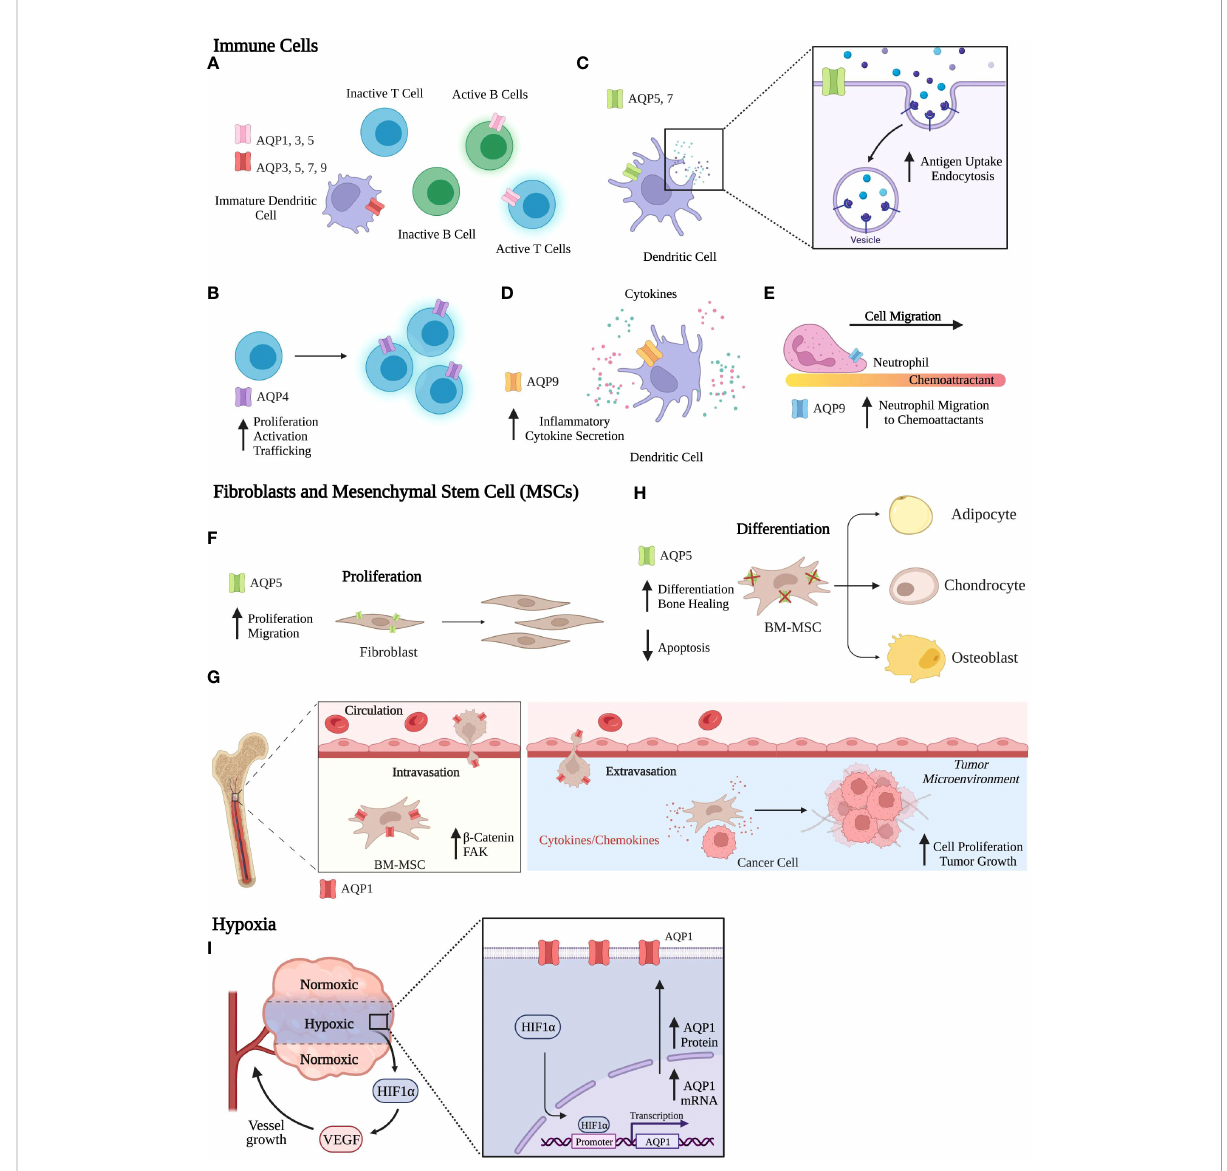
FIGURE 3 Functional Roles of Aquaporins. (A-E) Immune Cells . (A) AQP expression across various immune cells. (B) AQP4 is involved in T cell activation and proliferation. (C) In dendritic cells, AQP5 and AQP7 contribute to antigen uptake and endocytosis. (D) In dendritic cells, AQP9 expression aids in secretion of in fl ammatory cytokines. (E) AQP9 increases neutrophil migration to chemoattractants. (F-H) Fibroblasts and MSCs. (F) AQP5 expression in fi broblasts increases proliferation and migration. (G) AQP1 expression in BM-MSCs aids in migration, where BM-MSCs can interact with the TME to promote breast cancer progression. (H) AQP5 knockout in BM-MSCs increases differentiation and bone healing and reduces apoptosis rates. (I) Hypoxia. AQP1 mRNA and protein expression increase in response to hypoxia. Created with